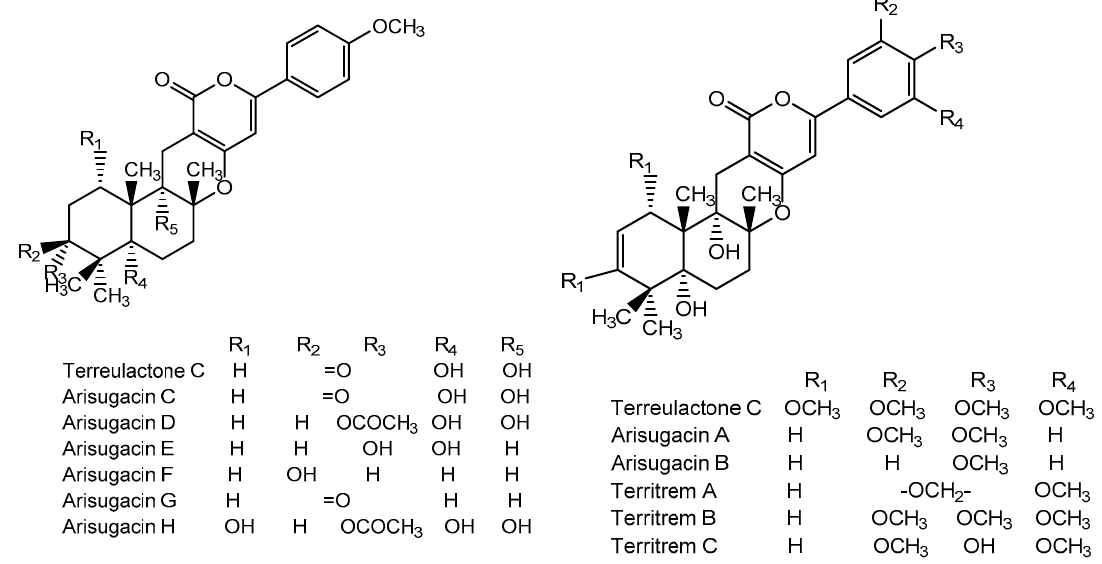
Figure 1. Structures of the arisugacins A–H, territrems A–C, and terreulactones C and